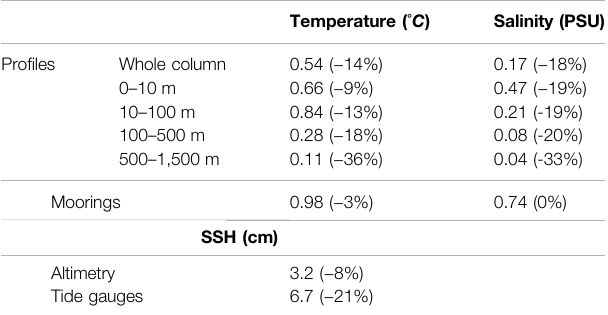
TABLE2| SummaryofestimatedRMSDcomparedtoobservationsforthewhole Mediterranean Sea. The value is for MEDREA24 and the percentage in parenthesis is the change from